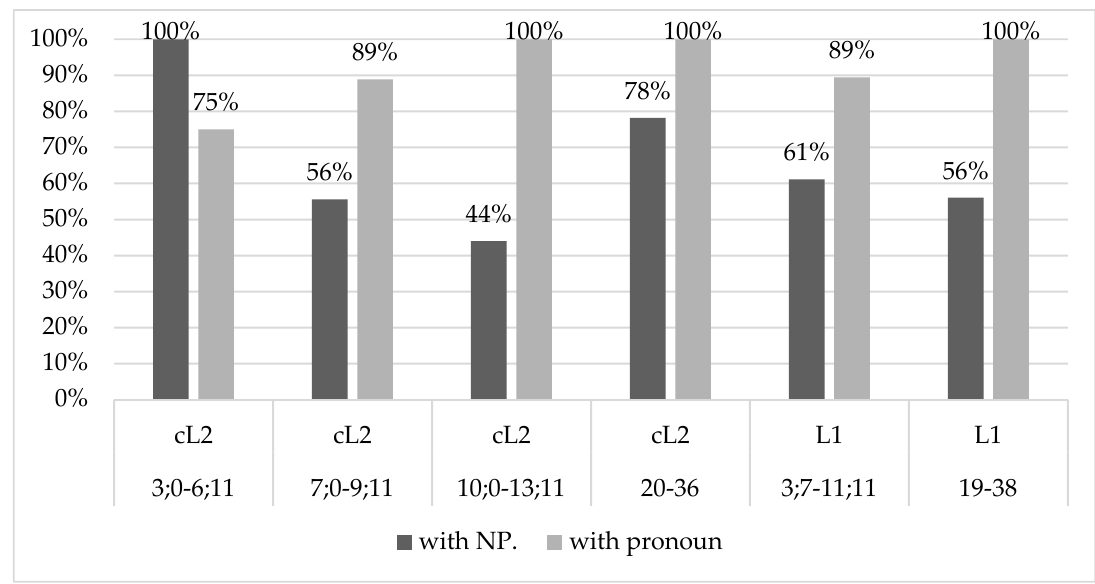
Figure 8. Acceptance of discontinuous word order in verb phrases with noun phrases (NPs) vs. pronouns in early sequential bilinguals (cL2) and monolinguals (L1).